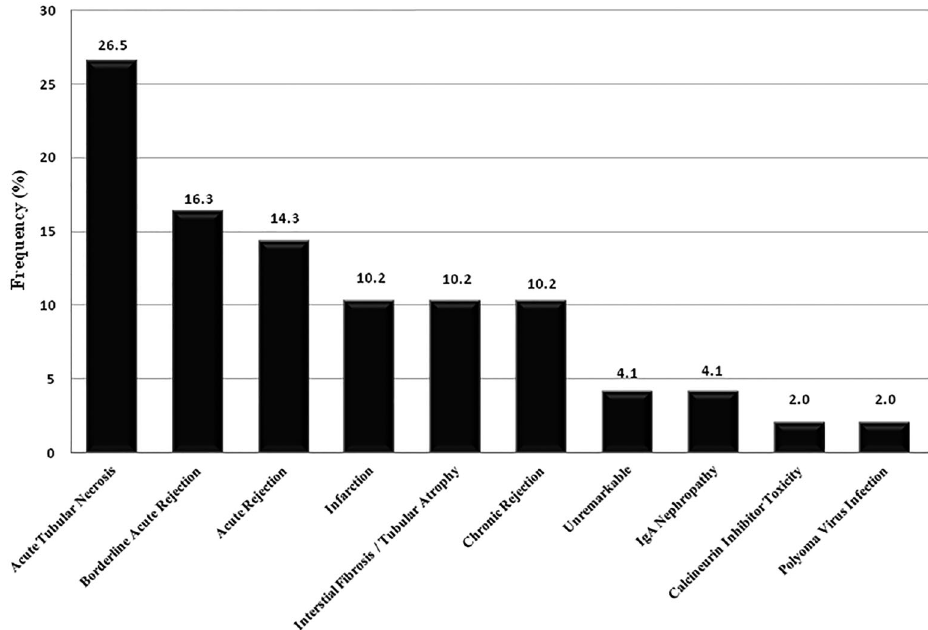
Figure 1. Frequency (%) of histopathological diagnoses from renal allograft biopsy specimens reported by the nephropathologist. IgA, immunoglobulin A.